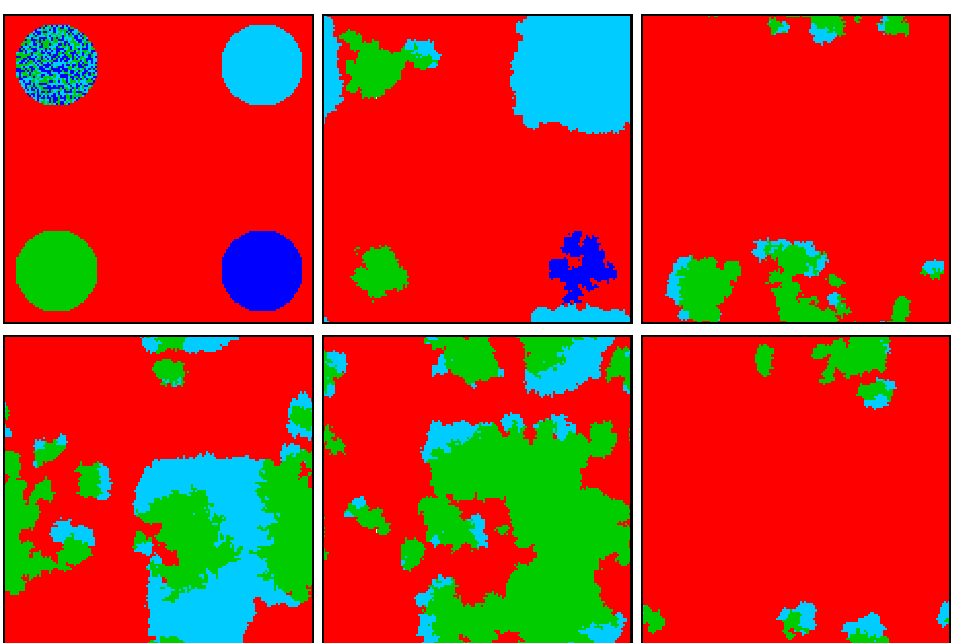
FIG. 10. Snapshots of the square lattice, showing a characteristic evolution from a prepared initial state, as obtained for (cid:2) ¼ 0 : 1 , (cid:1) ¼ 0 : 55 , and r ¼ 2 : 5 . Strategies D , P , R , and B are encoded with the same color as used in Fig. 4. Time runs from the top left panel toward the bottom right panel at 0, 100, 1800, 4100, 4240, and 4610 Monte Carlo steps, respectively. At 0 MCS, the game is initiated from the same prepared initial state, and for the same reason, as described in the caption of Fig. 4. At 100 MCS, it can be observed that strategies P (green) and R (dark blue) are both weaker than strategy D (red), and accordingly, their isolated islands shrink. Conversely, the combined strategy B is more effective when competing alone against the defectors, and thus the light blue island grows. Moreover, in the absence of defectors, strategy P can exploit rewarding strategies and spread fast in the bulk of the mixed domain (upper left circle). It is also worth pointing out that the B domain would grow endlessly in the sea of defectors if it did not meet the elementary strategy P that is able to exploit it. At 1800 MCS, the final solution is practically formed, and from here on, traveling waves dominate the spatial grid. At 4100 MCS, it can be observed that strategy B can spread toward strategy D , and based on this invasion, strategy B may control a significant portion of the lattice for a short period of time. At 4240 MCS, however, strategy P can easily invade the bulk of the B domain, but in the absence of this domain, strategy P itself becomes vulnerable against the defectors. This cycle of dominance is repeated from 4610 MCS onward, which is a very similar configuration as the one at 1800 MCS. Naturally, the oscillations become more intense as we approach the edge of the D þ P þ B phase in Fig. 5, and the evolution can easily terminate in an absorbing phase if the system size is not sufficiently